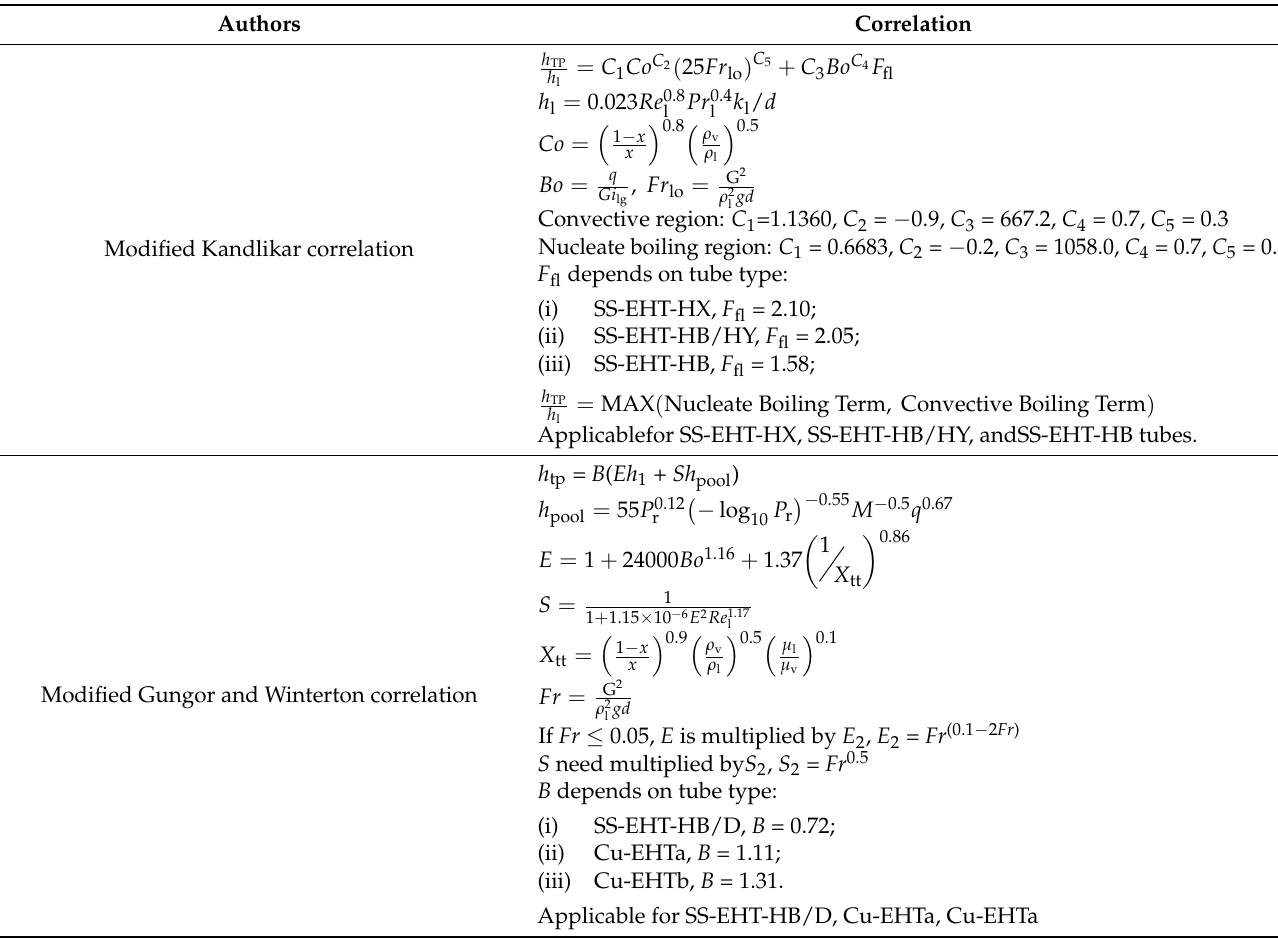
Table 3 details the modified correlations. Table 3. Modified